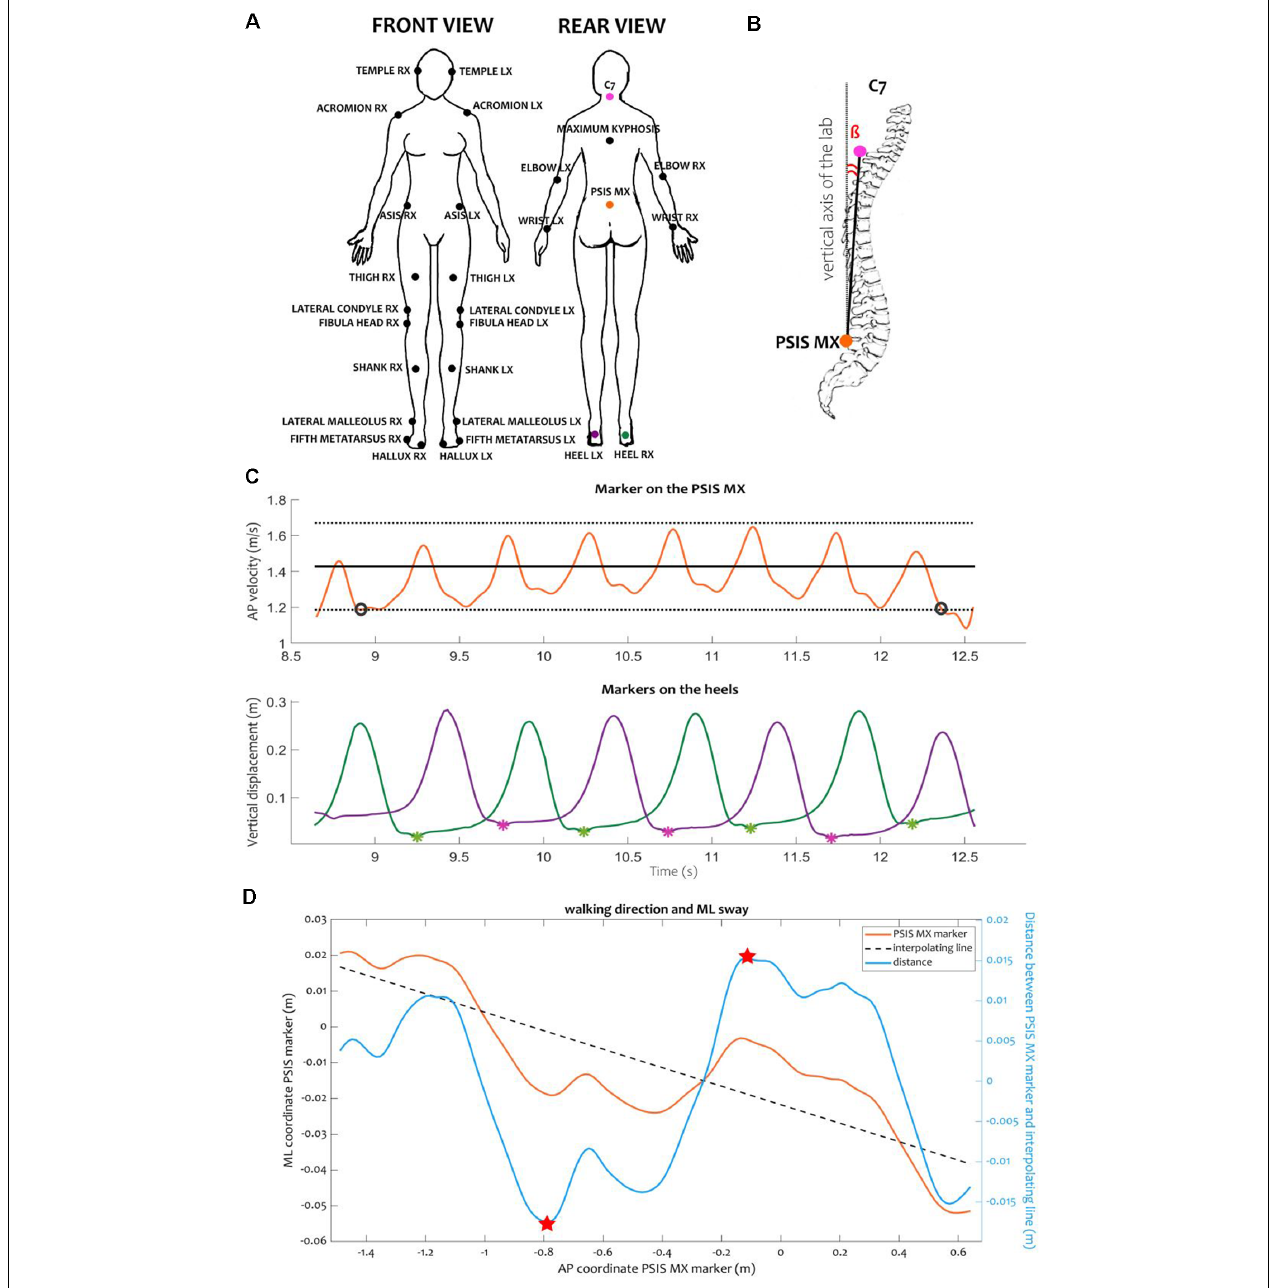
FIGURE 1 | Kinematic protocol and variables. (A) Position of the markers according to the LAMB protocol (Palmisano et al., 2019). Colored markers were used for the computation of kinematic events and variables. (B) Representation of the trunk inclination. Trunk inclination β was defined as the angle between the vertical axis of the laboratory and the vector connecting the markers placed on the middle point between the PSIS (PSIS_MX) and the C7 vertebra. (C) Example of computation of steady-state velocity and identification of heel contacts for one RW trial. We defined the steady-state velocity specific for each subject as the average (black solid line) ± the standard deviation (black dotted lines) of the AP velocity of the PSIS_MX marker computed in the central portion of the calibration volume. Only the interval during which the velocity was consistently inside this range (between the black circles) was considered for computing the gait cycle parameters. Inside the window at steady-state velocity, we identified the heel contacts as the local minima (asterisks) of the vertical tracks of the markers placed on the heels (green and purple lines for the right and left heels, respectively). (D) Example of ML sway and walking direction during a RW trial. We computed the ML sway as the range of the distance (light blue line) between the trajectory of the PSIS_MX marker in the transversal plane (orange line) and its interpolating line (black dashed line). The range was computed as the difference between the maximum and minimum values of the distance (indicated here as red stars). The direction of the walking trajectory was computed as the angular coefficient of the linear regression line interpolating the PSIS_MX trajectory in the transversal plane. Abbreviations: AP, anterior-posterior; C7, seventh cervical vertebra; ML, medio-lateral; PSIS, posterior-superior iliac spines.